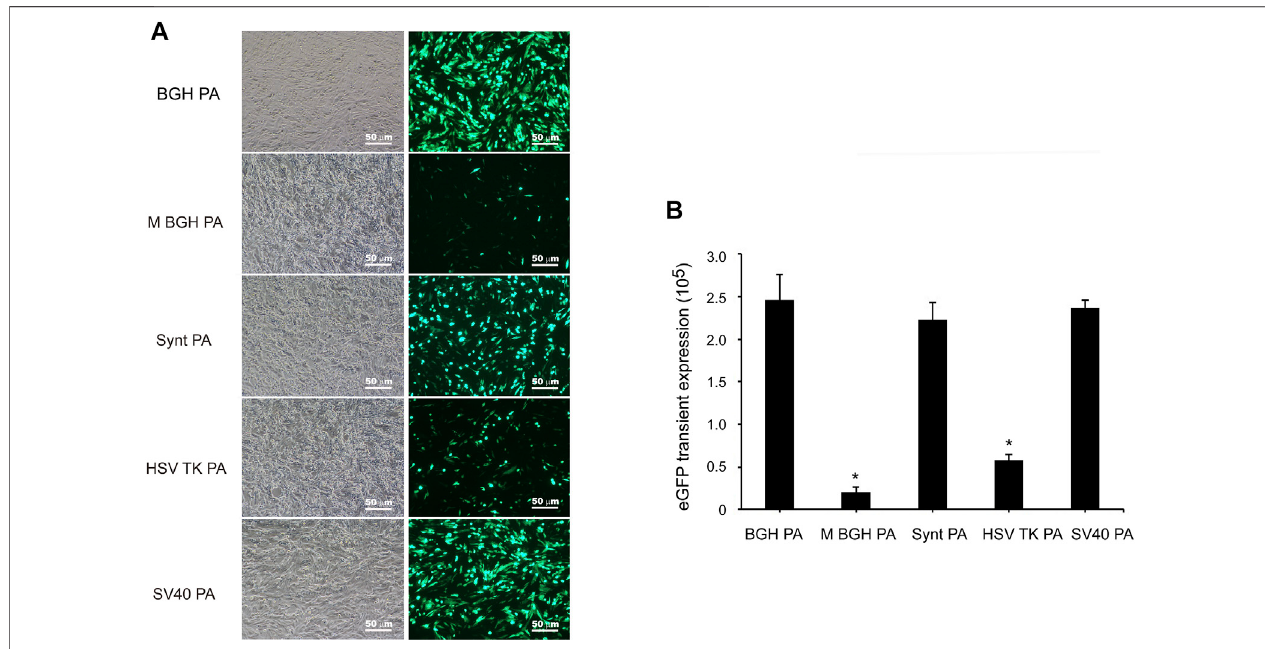
FIGURE2| Effect ofdifferentpoly Acontainingvector ontransient transgeneexpression. (A) Vectors containingdifferentpoly AweretransfectedintoCHO cellsat 48 post-transfection, fl uorescence intensity was observed under fl uorescence microscopy. (B) The cells were collected, and the mean fl uorescence intensity was measured by fl ow Cytometry, results are expressed as the mean values obtained from three independent experiments, and SEM is indicated (* p < 0.05).